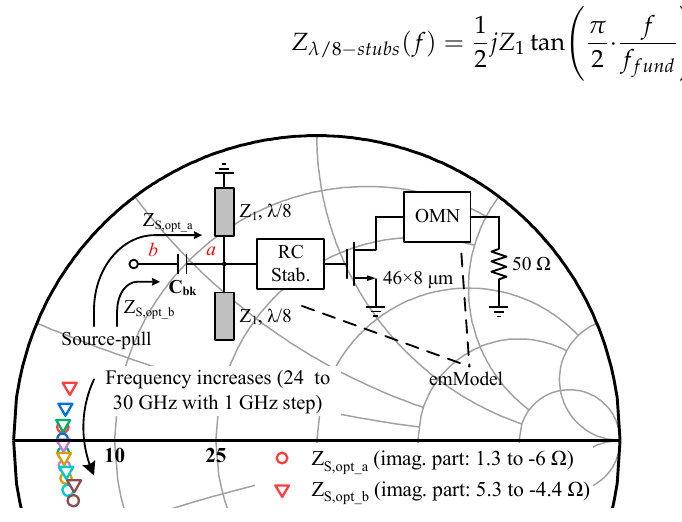
Figure 8. Optimal input impedances extracted from source-pull simulations.